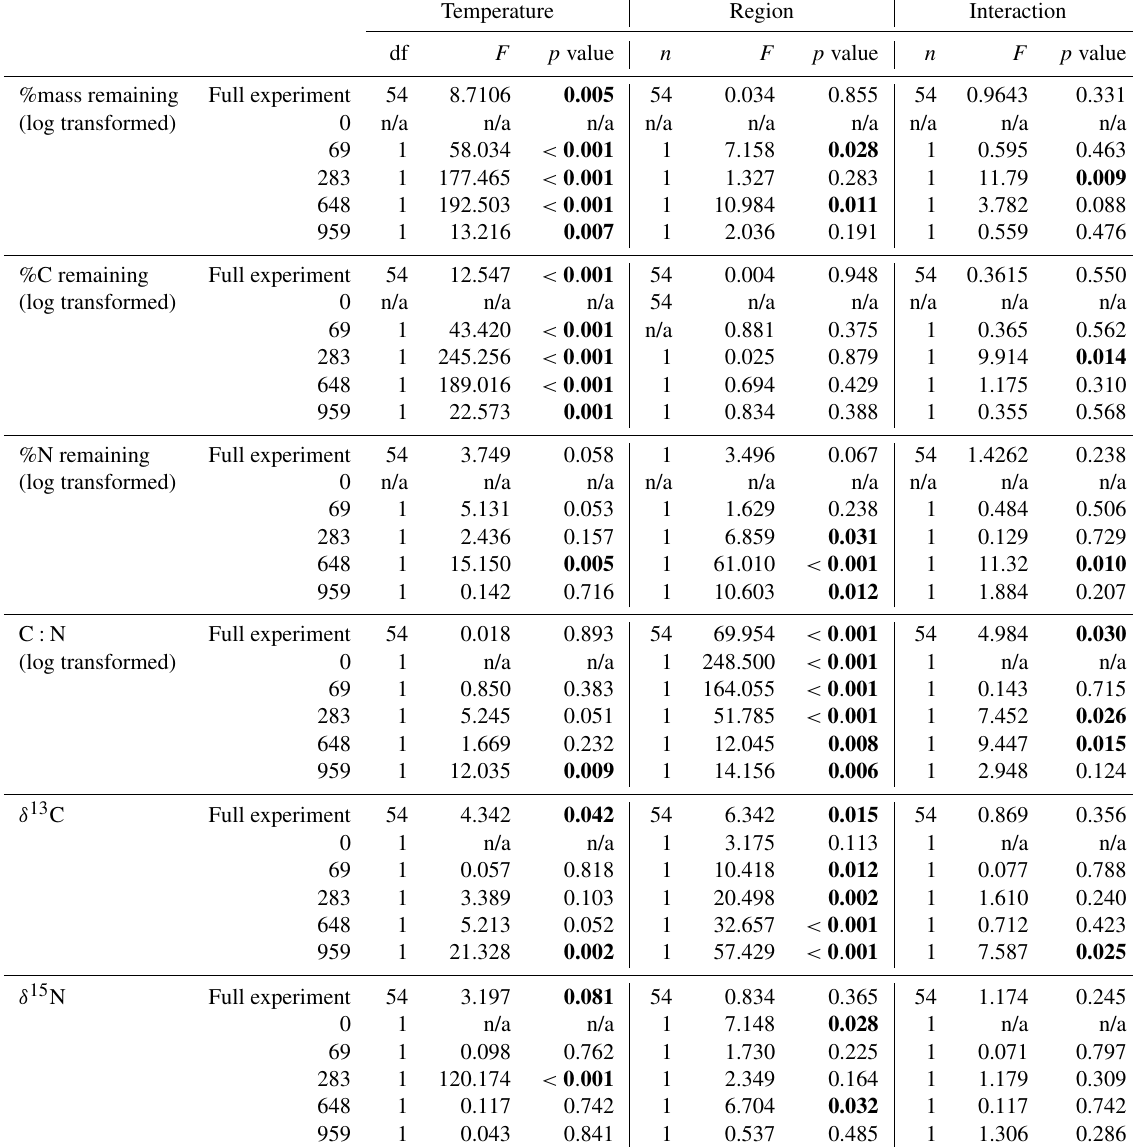
Table 2. Results from two-way ANOVA tests of the effects of collection site and incubation temperature on mass, C and N remaining, molar C to N ratio (C : N), and stable C ( δ 13 C) and N ( δ 15 N) isotope of the moss tissues. Results provided for both the full experiment (using a repeated measures ANOVA) and for each incubation time (using 2-way ANOVA). Bolded values are significant ( α = 0 .